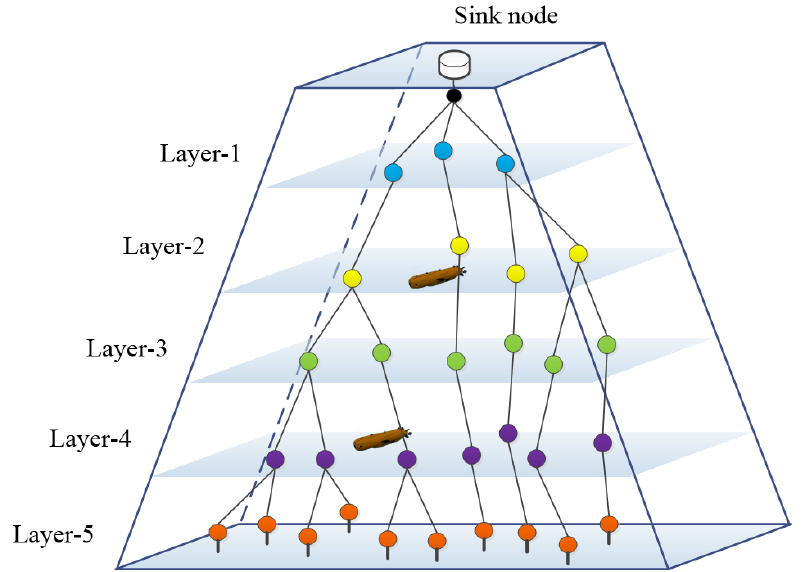
Figure 4. Five-hop data collection network connection diagram.